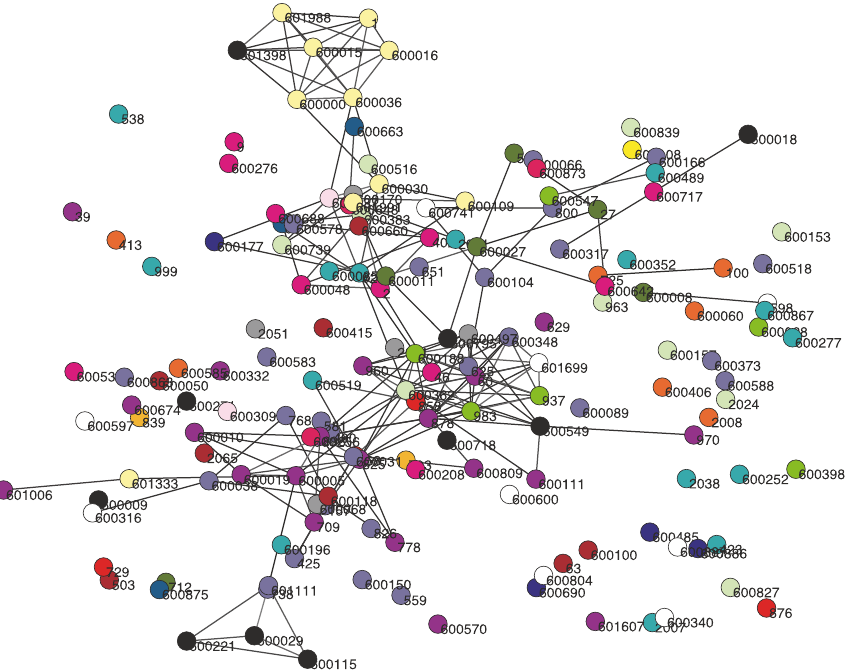
Figure 19: Asset graph of CSI163 with 𝑁 − 1 shortest